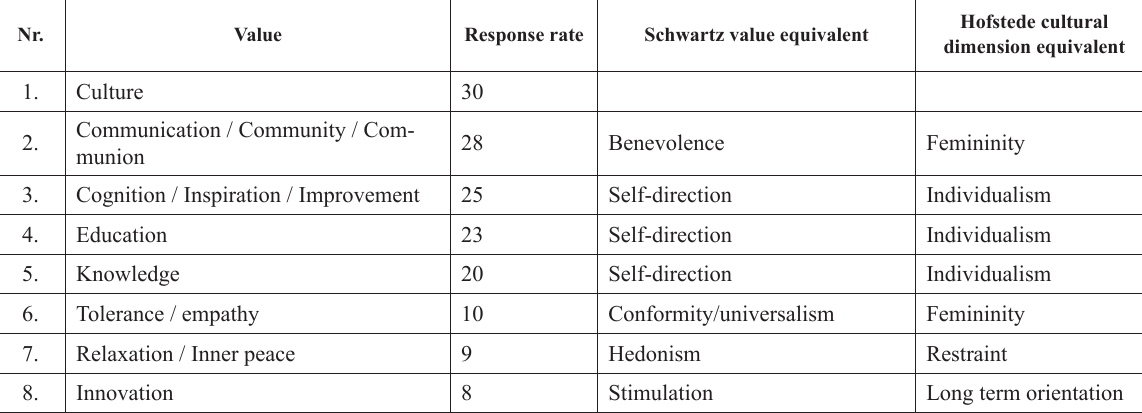
Table 3. Respondents’ values are associated with the Vilnius Book Fair Nr.